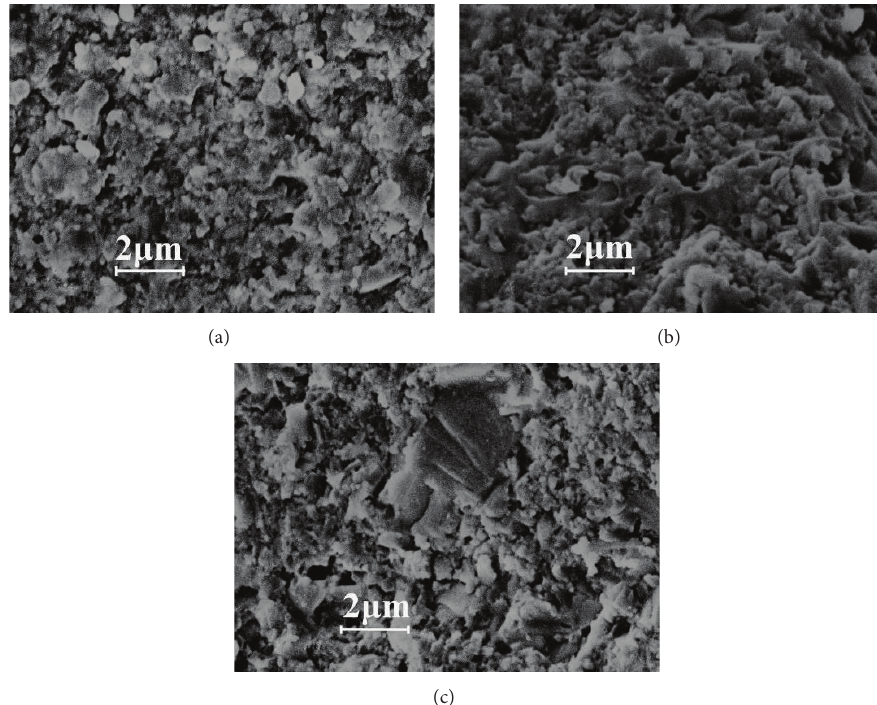
Figure 4: Typical SE SEM images on fracture surface of the as-prepared cermets with different amounts of Si 3 N 4 nanopowder: (a) 0wt.%, (b) 2wt.%, and (c) 5wt.%.